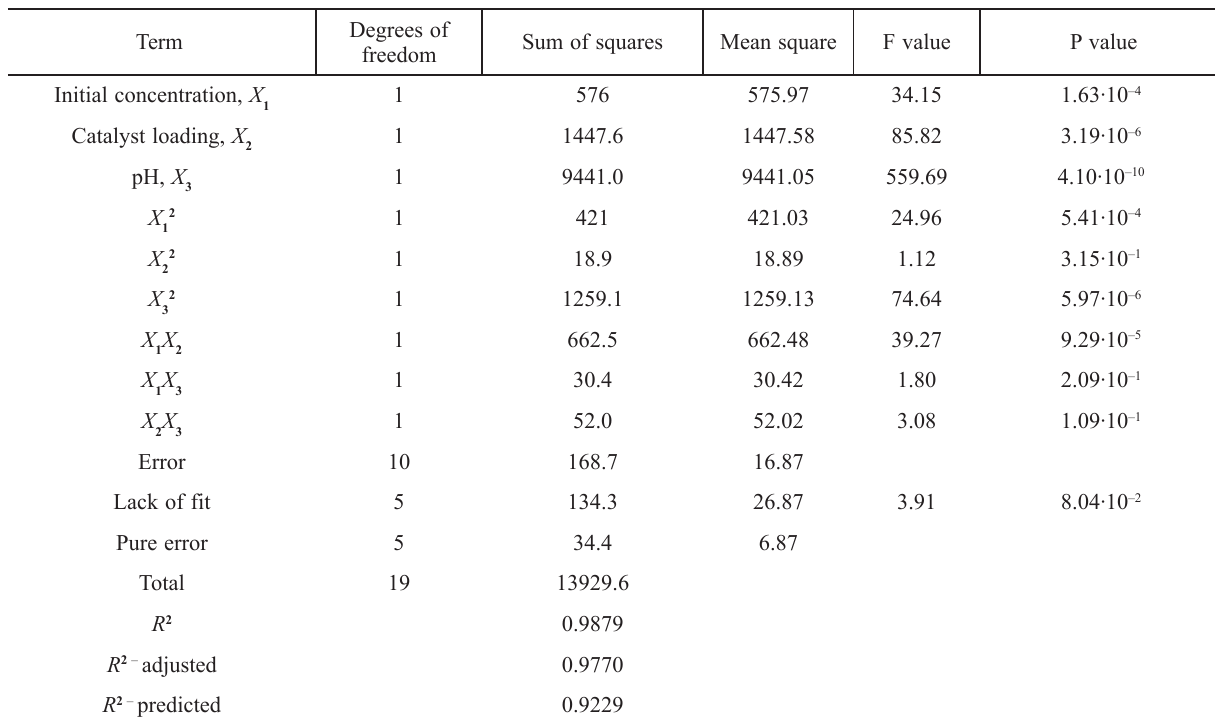
Table 4 – ANOVA of the response for decolorization of Rh 6G Degrees of Sum of squares Mean square F Term freedom